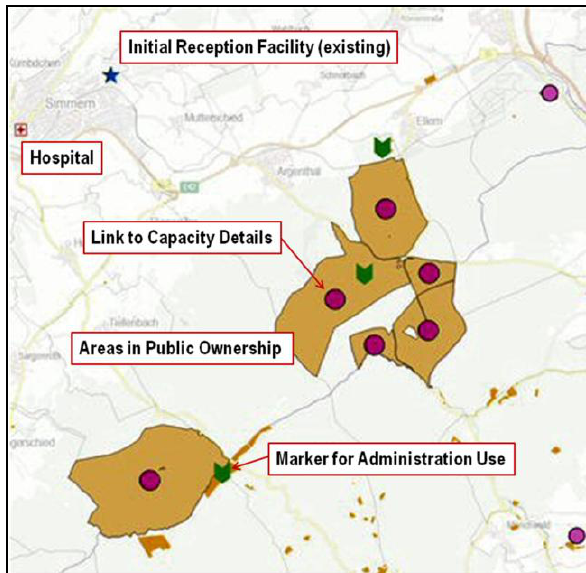
Figure 4: Administrative Web Portal for infrastructure and potential areas for refugees in public ownership (Bernkastel-Wittlich 2016 ).